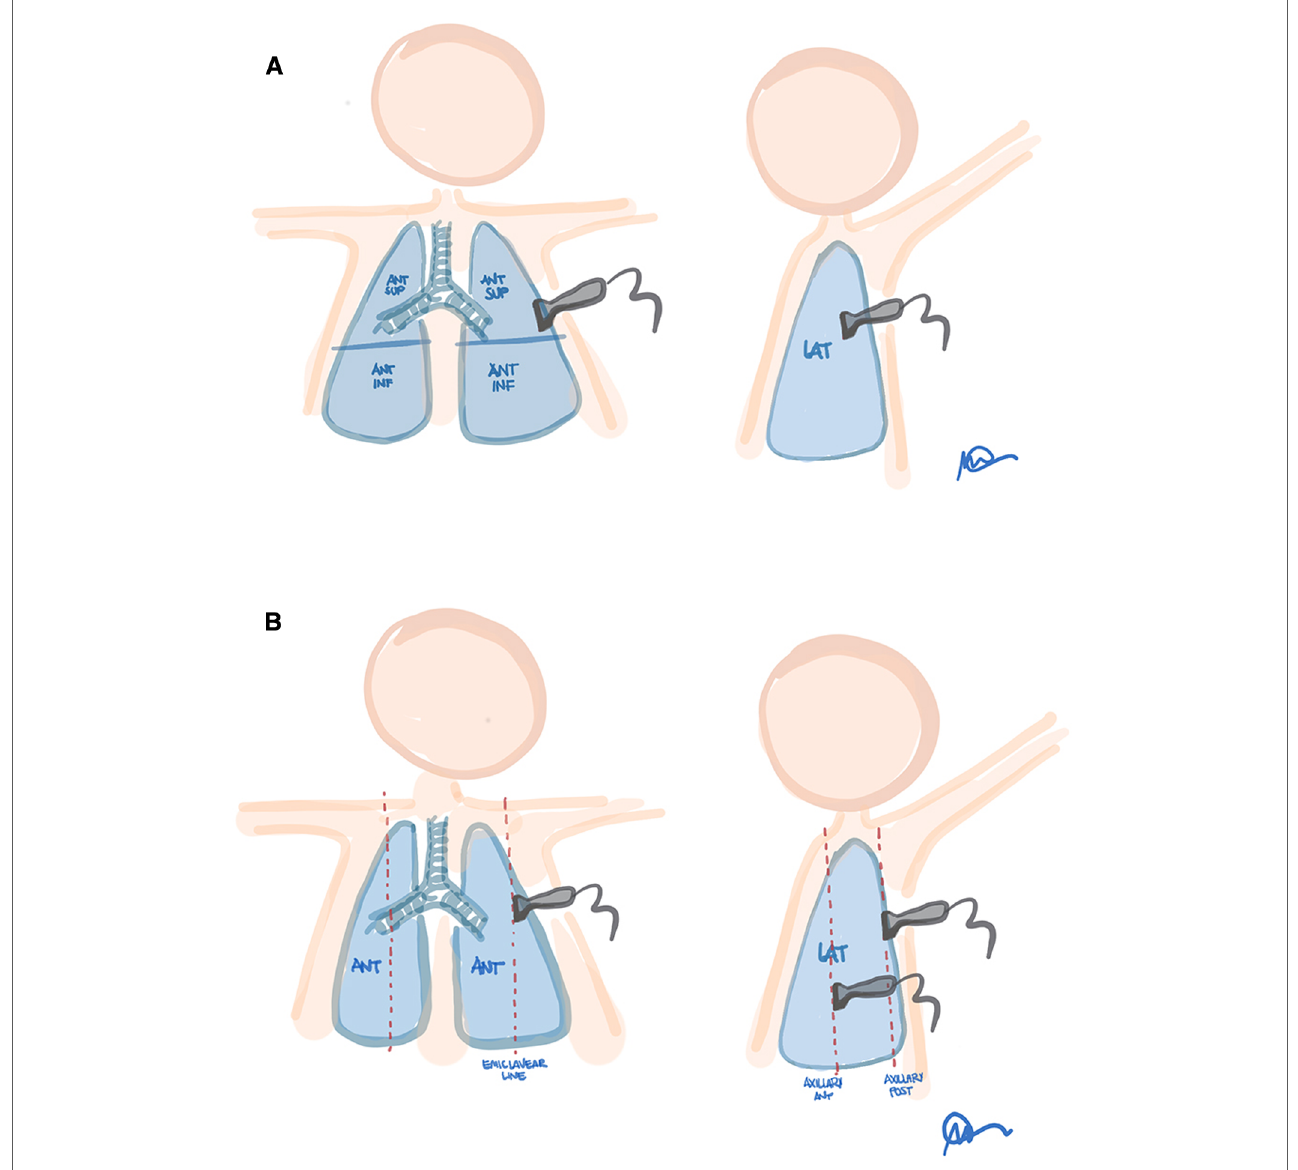
FIGURE 9 Proposed lung fi elds for 6-areas ultrasound scores. ( A ) Brat et al. (zones: antero-superior, antero- inferior and lateral for each hemithorax). ( B ) Raimondi et al. (zones: midclavicular, anterior axillary and posterior axillary lines, for each hemithorax). Modi fi ed with permission from Corsini et al.